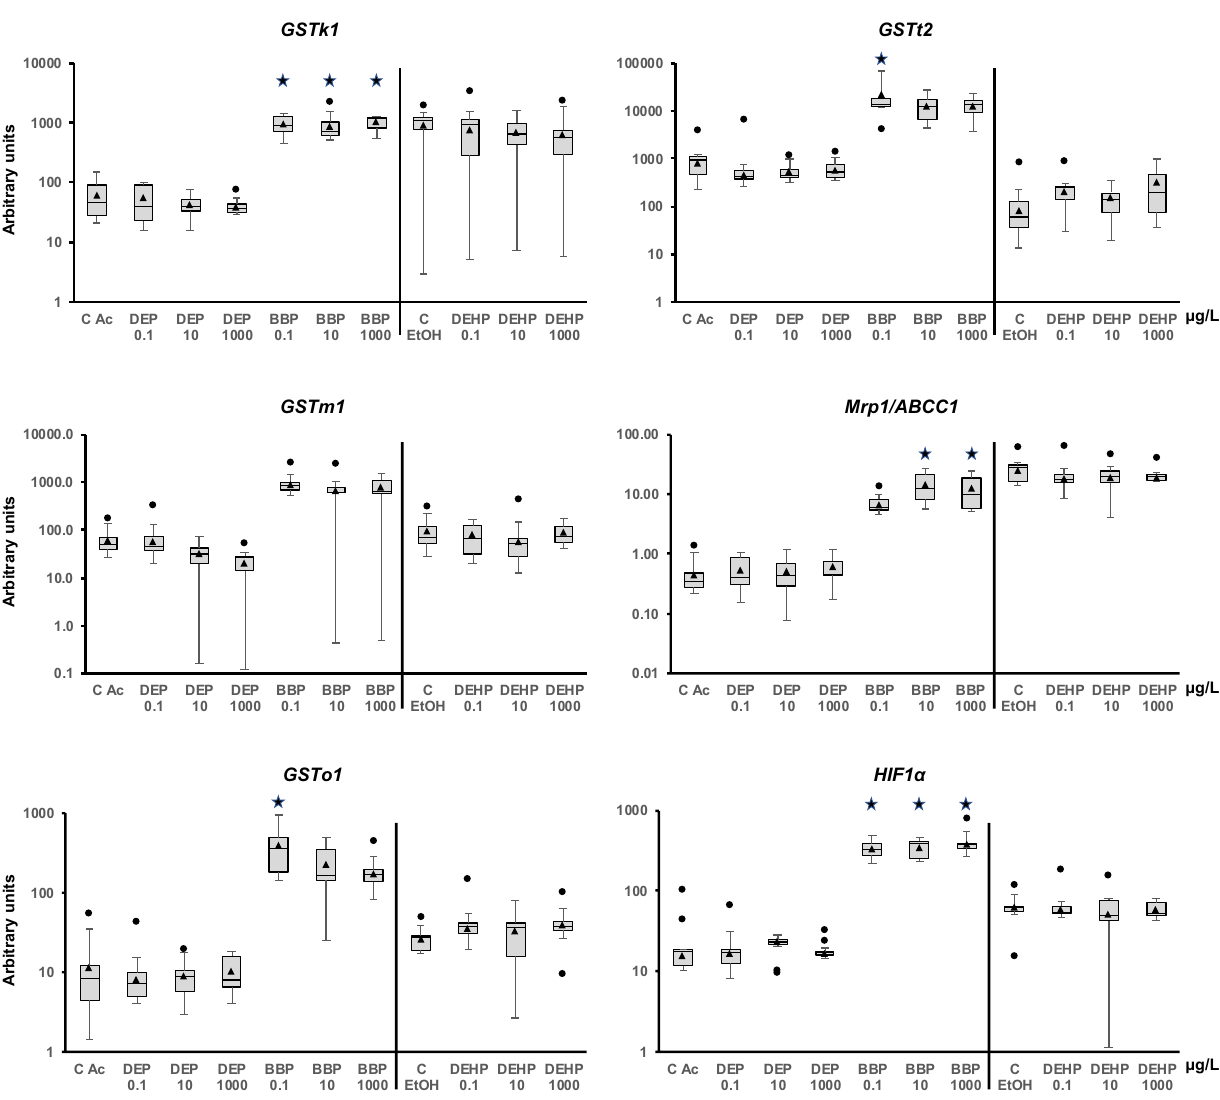
Figure 4. The mRNA levels of genes related to phase II ( GSTk1 , GSTm1 , GSTo1 , and GSTt2 ) and phase III ( MRP1 / ABCC1 ) detoxification and hypoxia ( HIF1α ) in adult Physella acuta after in vivo exposure to diethyl phthalate (DEP), benzyl butyl phthalate (BBP), and bis-(2-ethylhexyl) phthalate (DEHP) for 1 week at 19 °C. The mRNA levels were normalized using rpL10 , Act , PFKFB2 , and GAPDH were used. The comparison was performed with the solvent-exposed (EtOH, acetone) controls. Whisker boxes are shown (n = 9 individuals per box). The median is indicated by the horizontal line within the box, and the 25th and 75th percentiles are indicated by the boundaries of the box. The highest and lowest results are represented by the whiskers. The small triangle inside the box denotes the mean, and the outliers are shown (circles). Significant differences to the respective controls (asterisk) are indicated ( p <